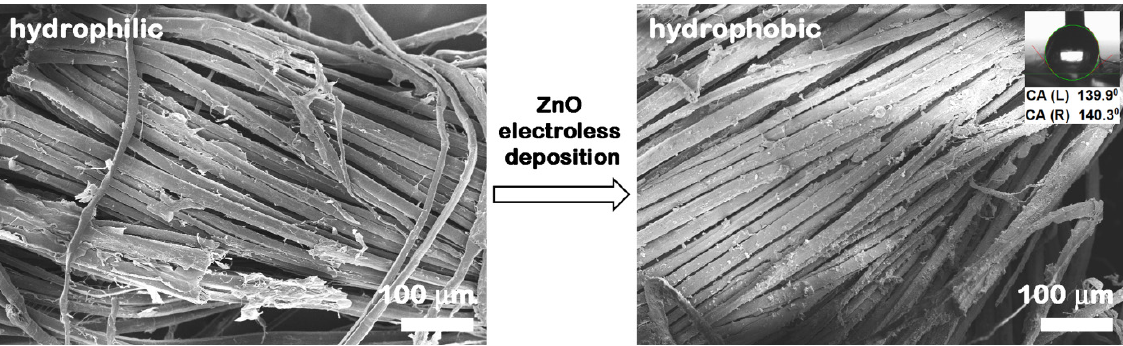
Figure 5. FESEM images of flax and ZnO-coated flax fibers as fabrics. In the inset is shown the optical photograph of the water droplet shape on the hydrophobic surface of ZnO-coated flax fabrics and the water contact angles for the corresponding sample.